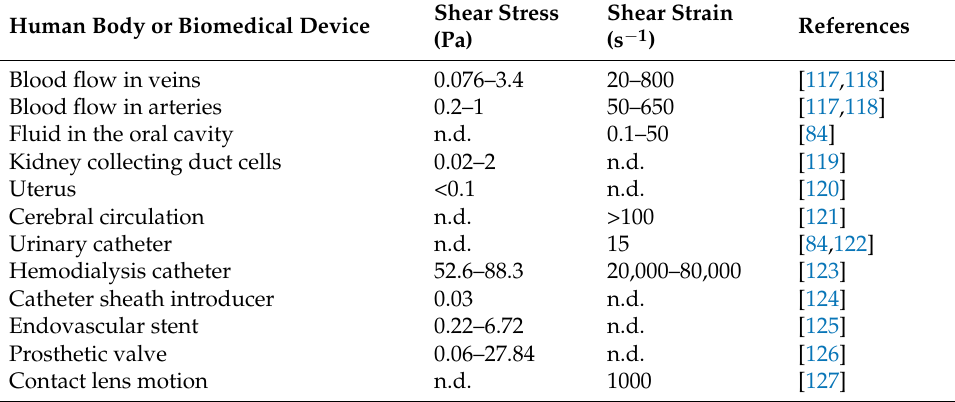
Table 6. Characteristic shear conditions found in biomedical